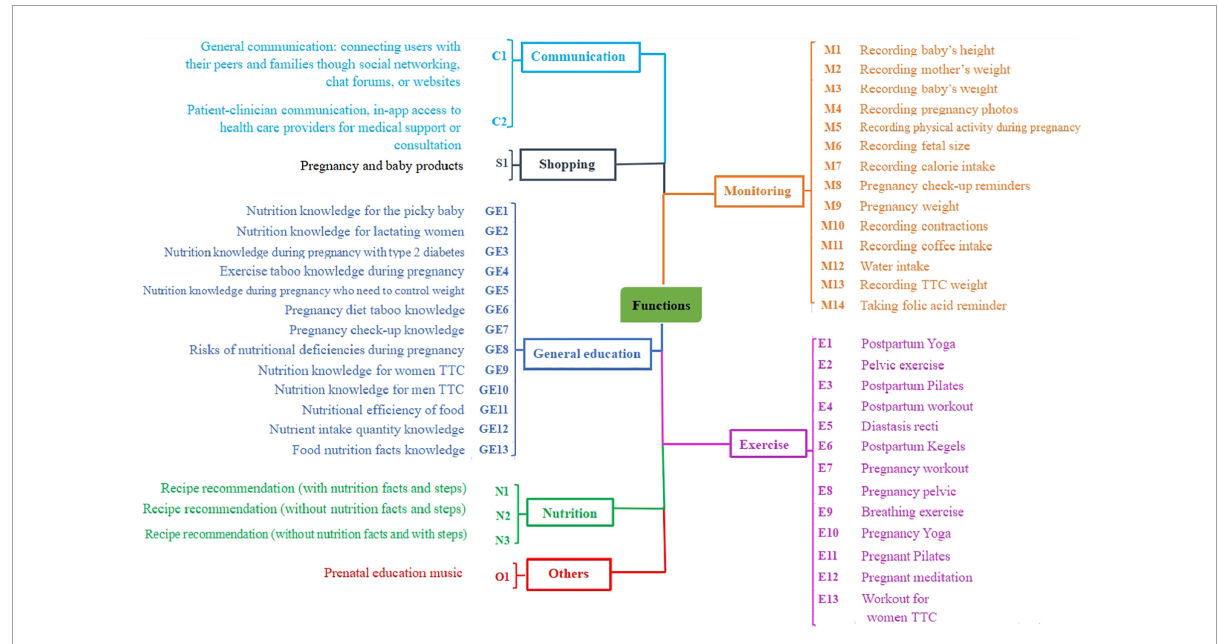
FIGURE2 The mind map depicts the primary and secondary models available in the United States and Chinese apps. TTC, trying to